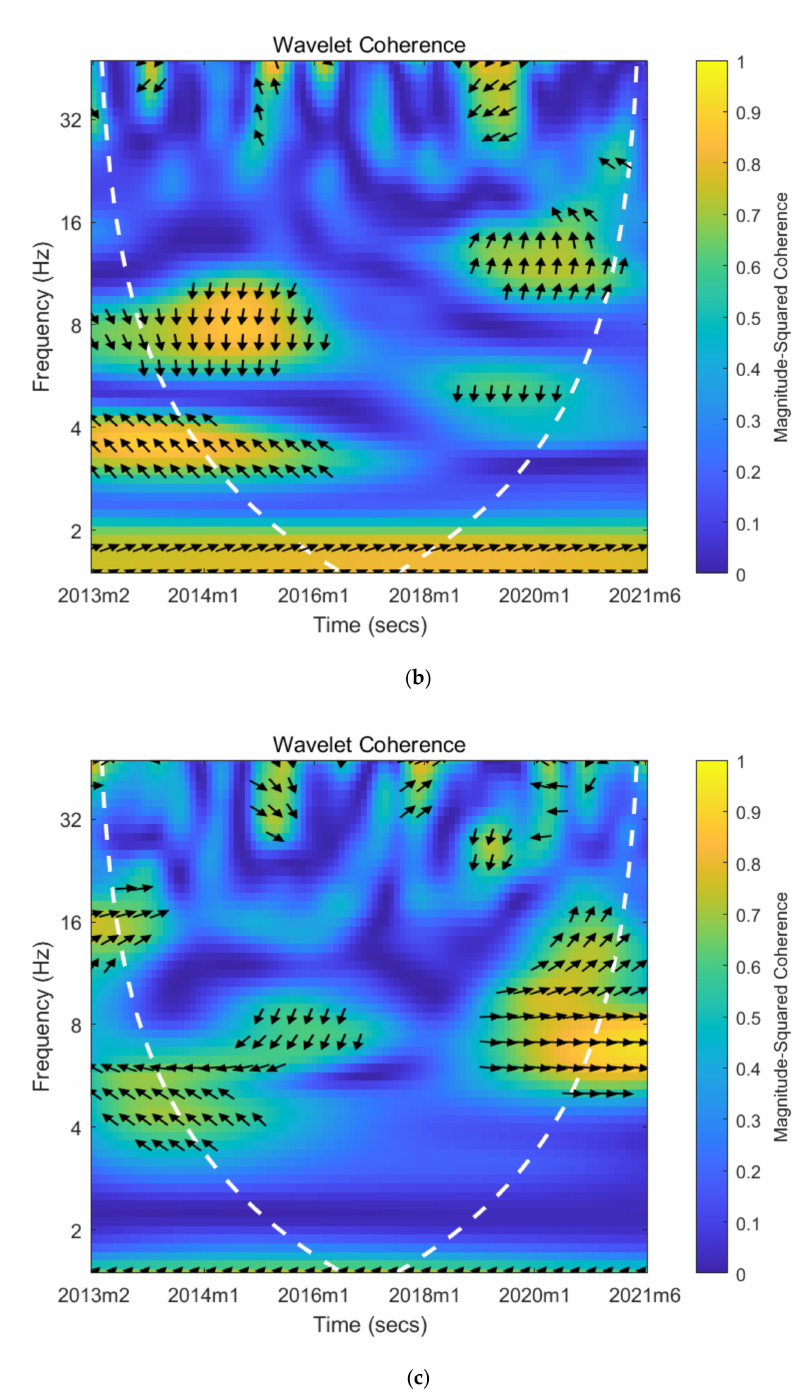
Figure 4. The various wavelet coherency map between different crude oil prices shocks and investor sentiment. ( a ) shows the wavelet coherency map of oil supply shocks and investor sentiment, ( b ) presents the wavelet coherency map of aggregate demand shocks and investor sentiment, while ( c ) exhibits the wavelet coherency map of oil-specific demand shocks and investor sentiment. The data span from February 2013 to June 2021. Time and frequency are represented on the horizontal and the vertical axis, respectively. The color of a region from blue to yellow implies the coherence correlation between crude oil prices shocks and investor sentiment become greater. The arrows show the correlation and lead lag relationship between crude oil prices shocks and investor